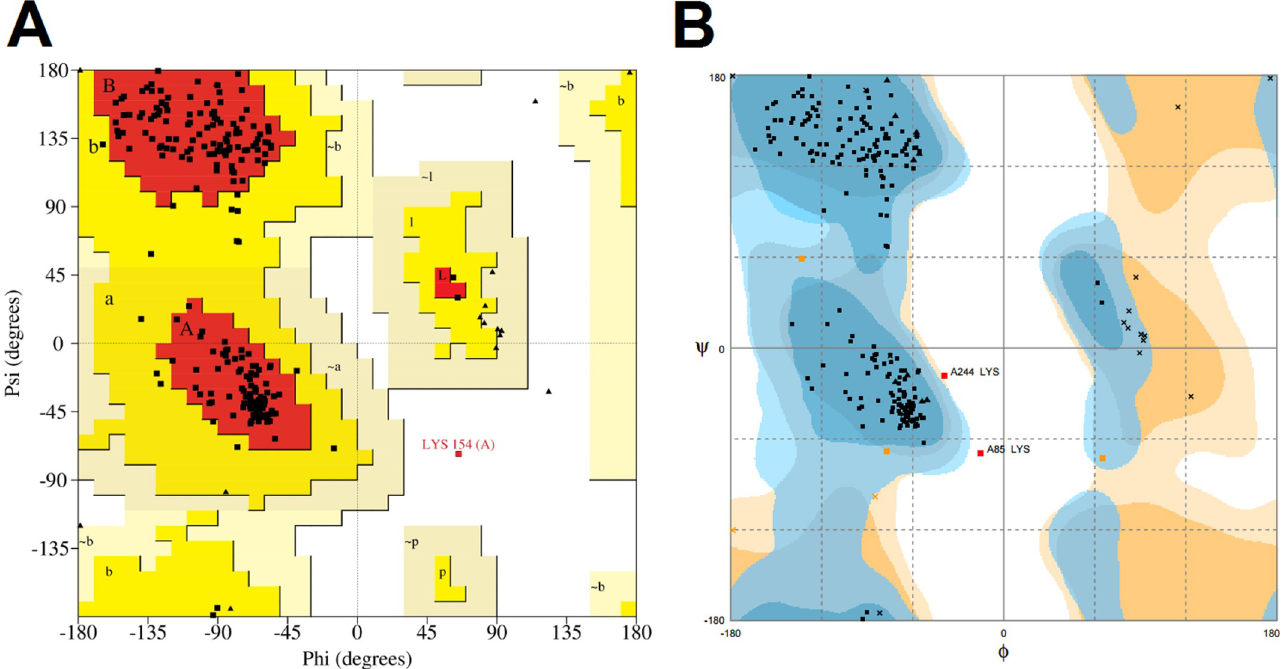
Fig 4. Validation of the in silico predicted model of BDNF by PROCHECK and RAMPAGE. (A) PROCHECK’s Ramachandran plot shows that the in silico structure of BDNF. Most residues (90.8%) are located in the most favored regions, while 8.8% are in additional allowed regions, and only 0.5% in disallowed regions, configuring a high-quality model. (B) RAMPAGE’s Ramachandran plot of the in silico structure of BDNF. This structure is also considered as a high- quality model because it shows 97.1% of its residues on favored regions, 2.0% on allowed regions, and 0.8% on not allowed regions.